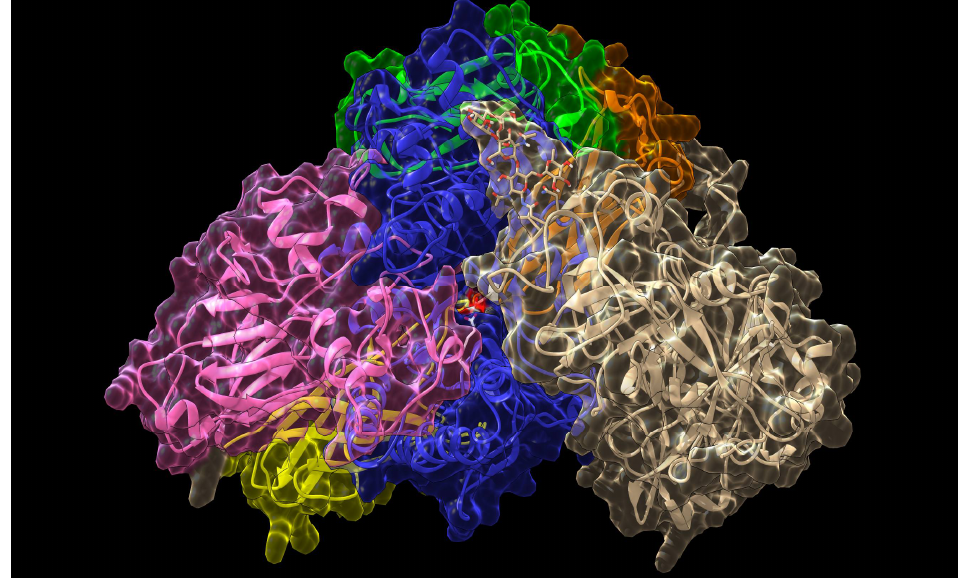
Figure 8. Docking prediction of γC interaction with GH2 β-mannosidase using FRODOCK software. One of the glycosylations described by Schiarea et al. [23] (Man 2 (Fuc) GlcNAc 2 ) was added to N131 with the GlyProt tool and is shown in stick representation. γC is tan colored, whereas β-mannosidase structural domains are colored as reported in Figure 6.